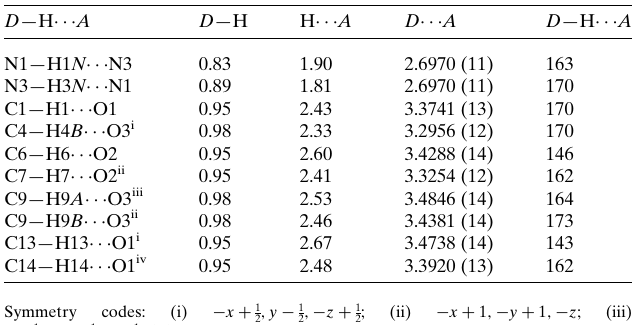
Table 2 Experimental details. Crystal data Chemical